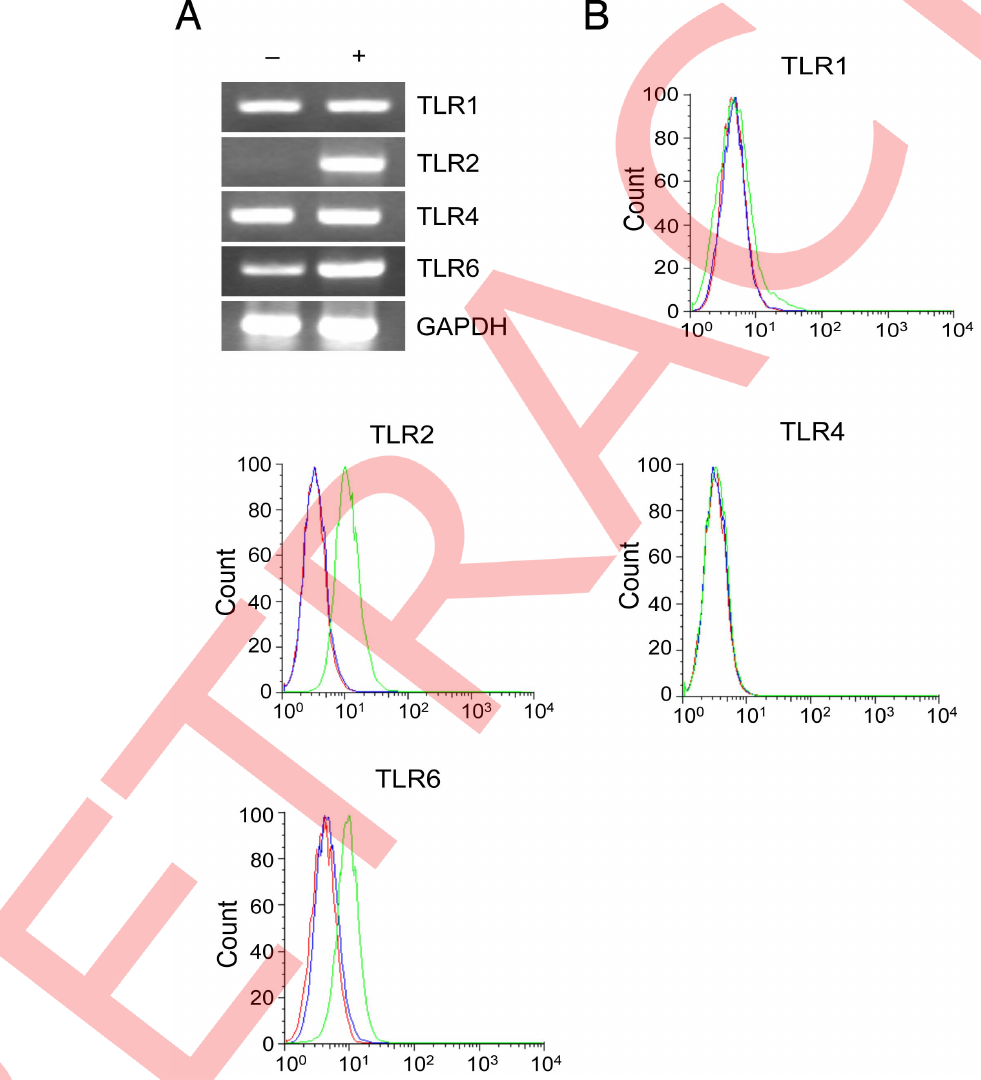
Figure 1. OmpA of S.flexneri 2a induces expression of TLR2 and TLR6 in B cell. ( A ) Splenic B cells were stimulated with OmpA (5 m g/ml), total RNA was extracted after 3 h and subjected to RT-PCR using the appropriate primer. PCR products were quantified and expressed as the ratio of each product to GAPDH band density. The data are representative of three independent experiments. ( B ) Purified splenic B cells were incubated in the absence (red line) or presence (green line) of OmpA (5 m g/ml) for 6 h. Cells were harvested and assayed for cell surface expression of TLR1, TLR2, TLR4, and TLR6. The blue lines represent the isotype control antibodies. Representative data from three independent experiments are shown. doi:10.1371/journal.pone.0109107.g001 PLOS ONE |